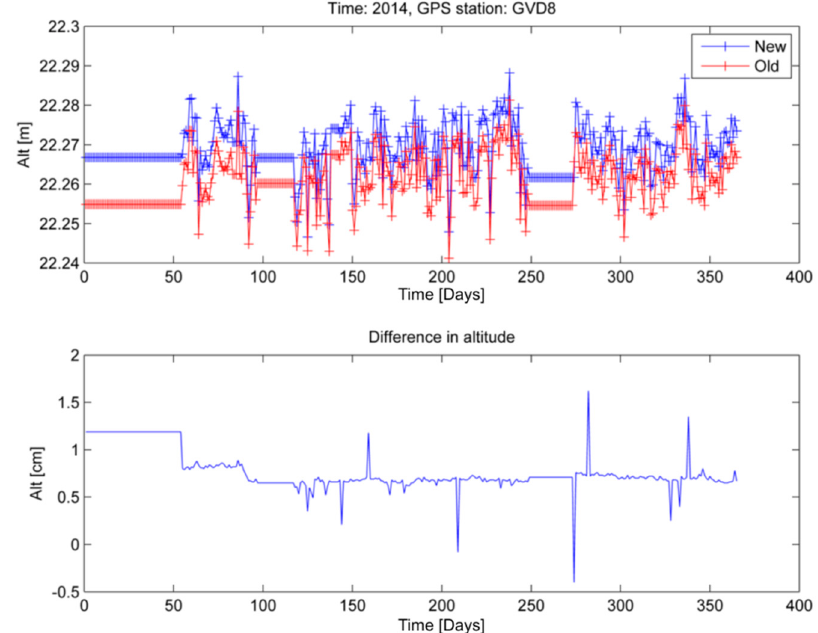
Figure 13. Upper image: The GVD8 altitude (height) daily solutions over 2014 using the IGS (“old”) and the Geo++ (“new and calibrated”) antenna parameters. Lower Image: Residuals between the two solutions in the altitude (height) determination for the GVD8 Cal/Val site.